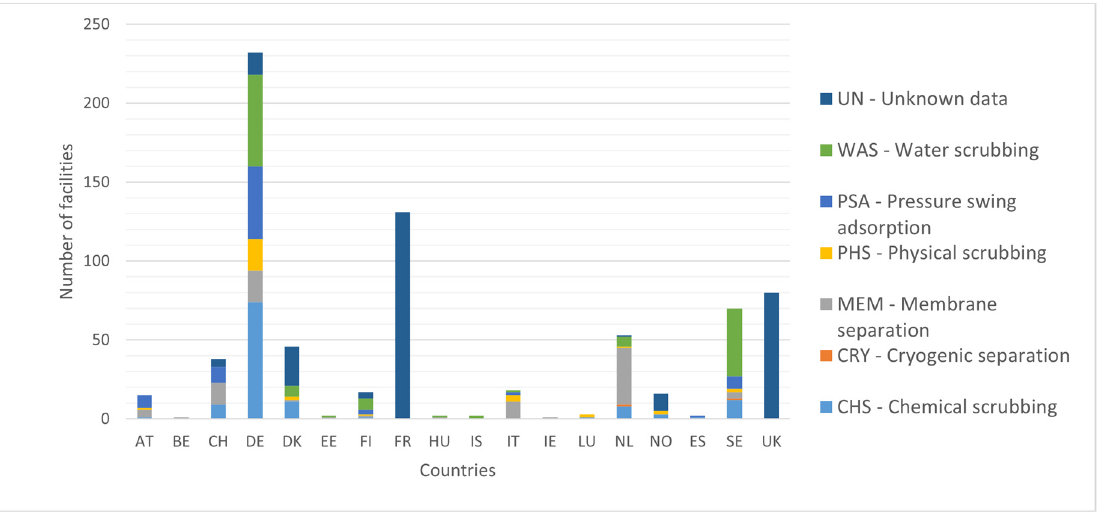
Figure 9. Distribution of facilities per upgrading process in EU member states, UK and Norway (according to [136]).